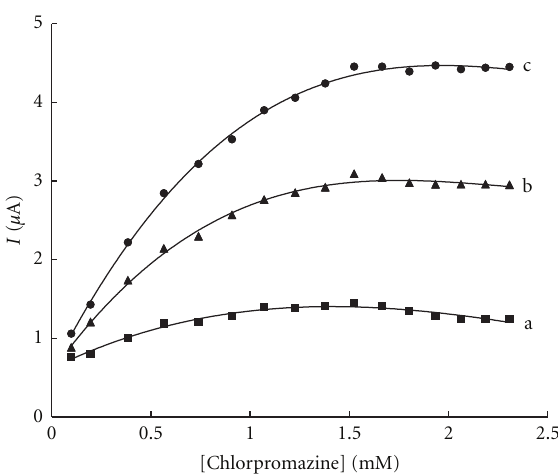
Figure 3: E ff ect of CPZ concentration on the anodic peak current of CAP. [CAP]: a: 0.1 mM, b: 0.25 mM, and c: 0.5mM. Scan rate 50mVs − 1 ; pH 4.0.